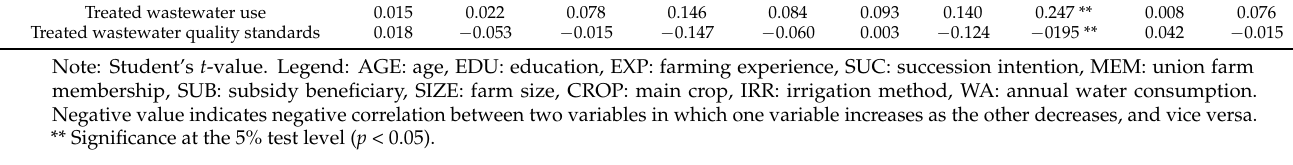
Table 10. Regression model between wastewater use plus quality standards and farmers’ sociodemographic characteristics. Variable Treated wastewater use